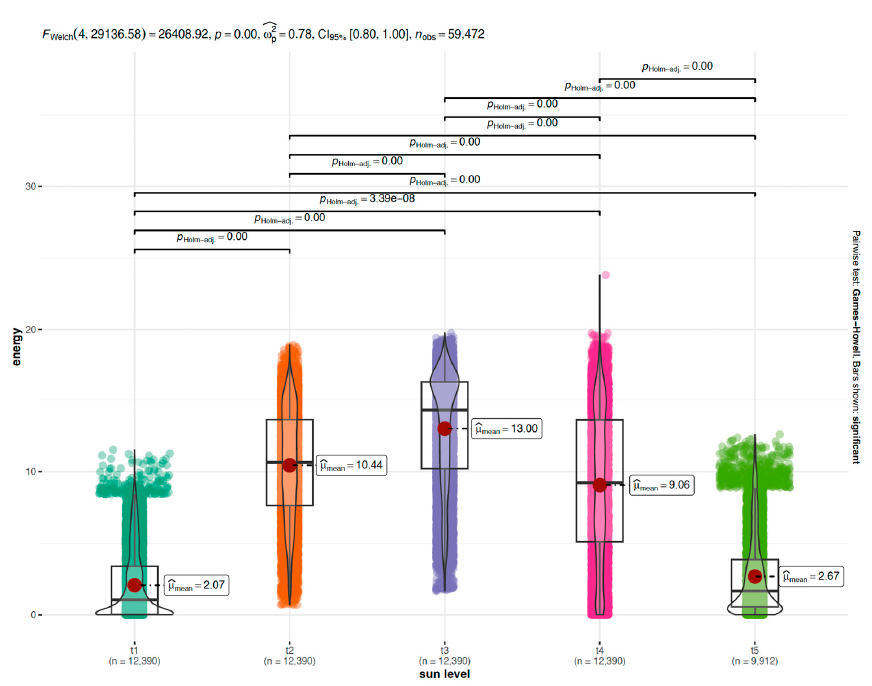
Figure A2. Equal variance and normality assessments on energy at different sun levels. ( a ) Residuals vs. fitted. ( b ) Normal Q-Q.